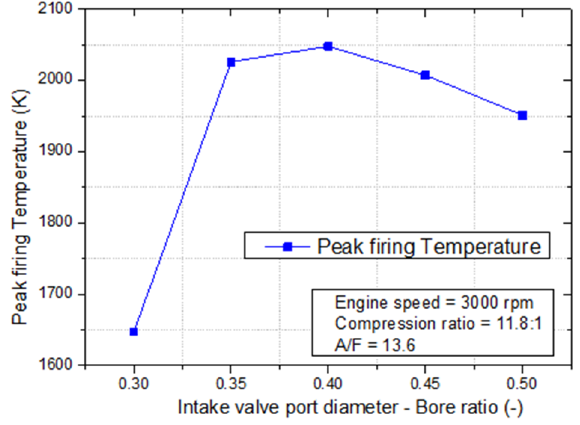
Figure 6. Peak temperature versus IPD/B.